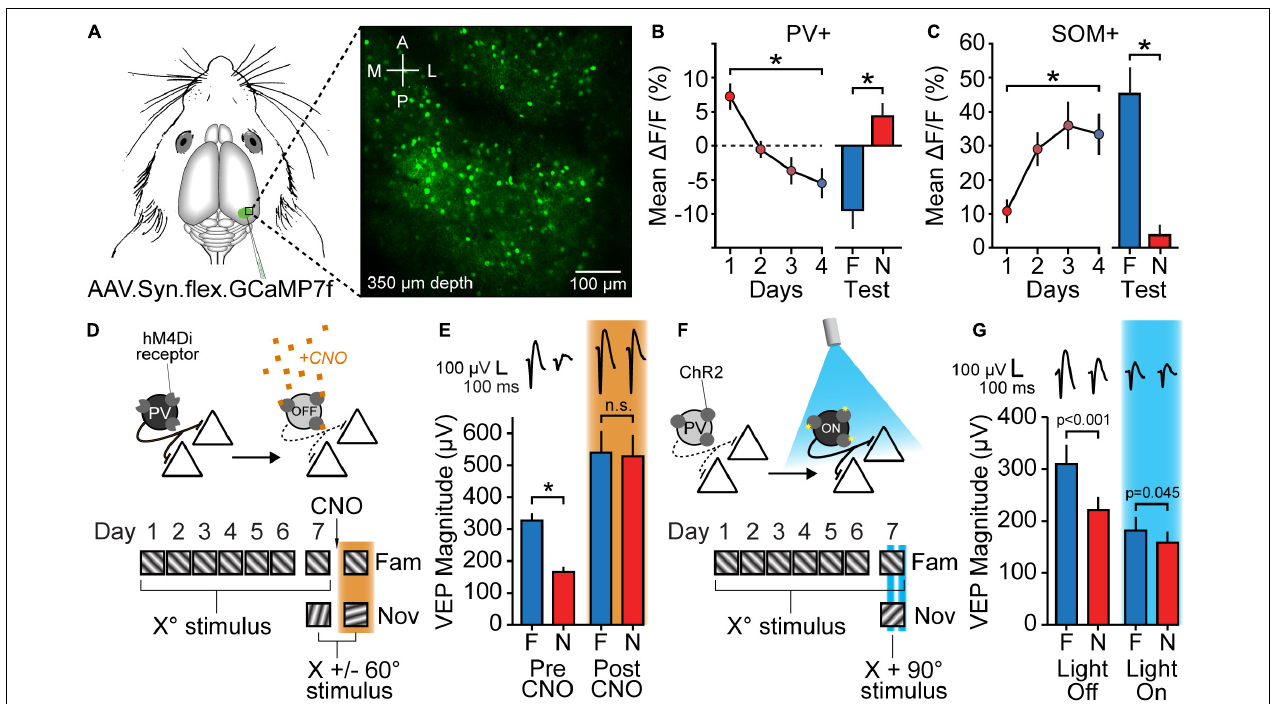
FIGURE 3 | Inhibition plays a role in SRP expression. (A) Mice expressing Cre recombinase in either PV+ or SOM+ inhibitory neurons were injected with a Cre-dependent GCaMP7f virus in V1. Activity in PV+ or SOM+ cells in L4 was then recorded using a 2-photon microscope. (B) Over the course of SRP induction, PV+ cells showed a significant decrease in stimulus-evoked fluorescence, eventually displaying suppression below baseline levels. PV+ activity for N stimuli was also significantly increased relative to activity for F stimuli. (C) SOM+ cells showed the opposite pattern of changes to PV+ cells, with an increase in stimulus-evoked fluorescence over the course of SRP induction and a significant decrease in fluorescence in response to N stimuli relative to F stimuli. (cid:49) F / F calculated as F stim – F gray / F gray . Replotted from Hayden et al. (2021). (D,E) Chemogenetic suppression of PV+ cells occludes SRP. (D) PV-Cre mice were injected with a virus expressing a Cre-dependent inhibitory DREADD receptor (hM4Di). The mice then underwent a standard SRP protocol, and following the familiar/novel test on day 7 received a systemic injection of CNO in order to activate hM4Di receptors and suppress PV+ cell activity. 1 h later mice viewed the original familiar stimulus and a new novel stimulus. (E) Mice showed normal SRP expression before CNO injection, but after injecting CNO to suppress PV+ cell activity mice showed an increase in VEP magnitude which eliminated the familiar-novel difference. (F,G) Optogenetic activation of PV+ cells partially reverses SRP. (F) PV-Cre mice were injected with a virus expressing Cre-dependent ChR2 and implanted with an optic fiber above bV1. Following SRP induction, mice viewed familiar and novel stimuli with blue-light activation of PV+ cells on alternating blocks on the test day. (G) Mice showed normal SRP expression during blocks in which PV+ cells were not activated by blue light, but the familiar-novel difference was significantly reduced for light-on blocks, due to a reduction in VEP magnitude. Panels (D–G) replotted from Kaplan et